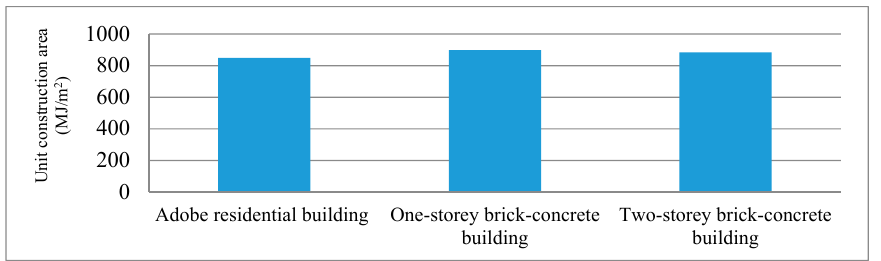
Figure 8. Energy demand of building erection (MJ).